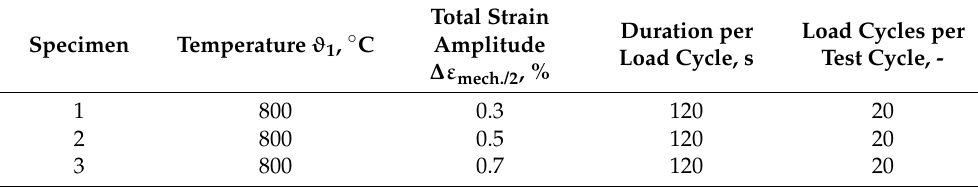
Table 1. Test parameters of the modified isothermal LCF tests .